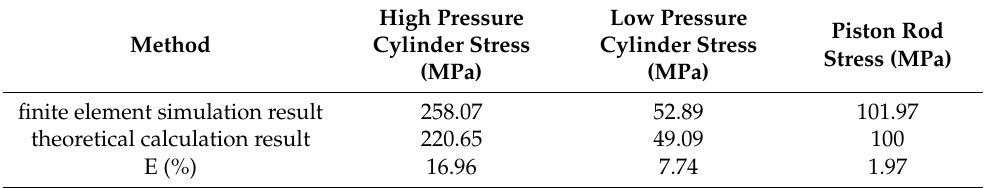
Table 7. Comparison between simulation results and theoretical calculation